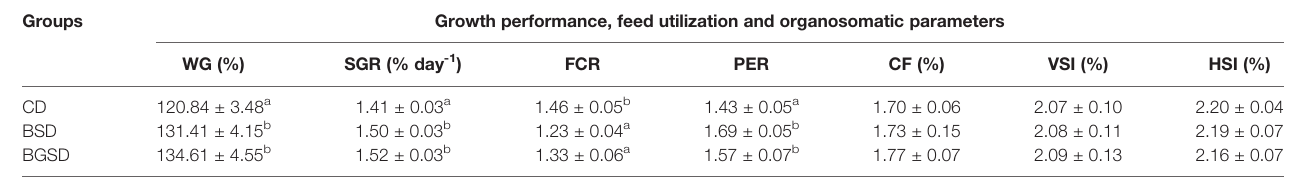
TABLE 3 | Growth performance, feed utilization, and organosomatic indices of red sea bream supplemented with the experimental feed additives. Groups Growth performance, feed utilization and organosomatic